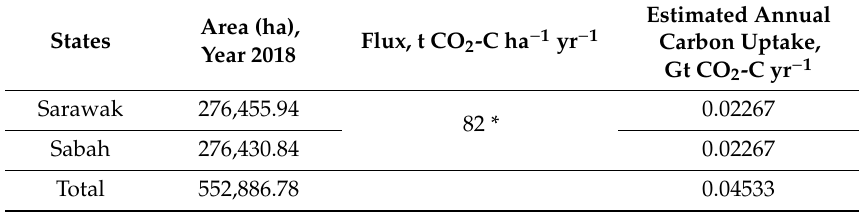
Table 10. Estimated oil palm plantation on forest annual carbon-CO 2 uptake in Sarawak and Sabah, Malaysia.